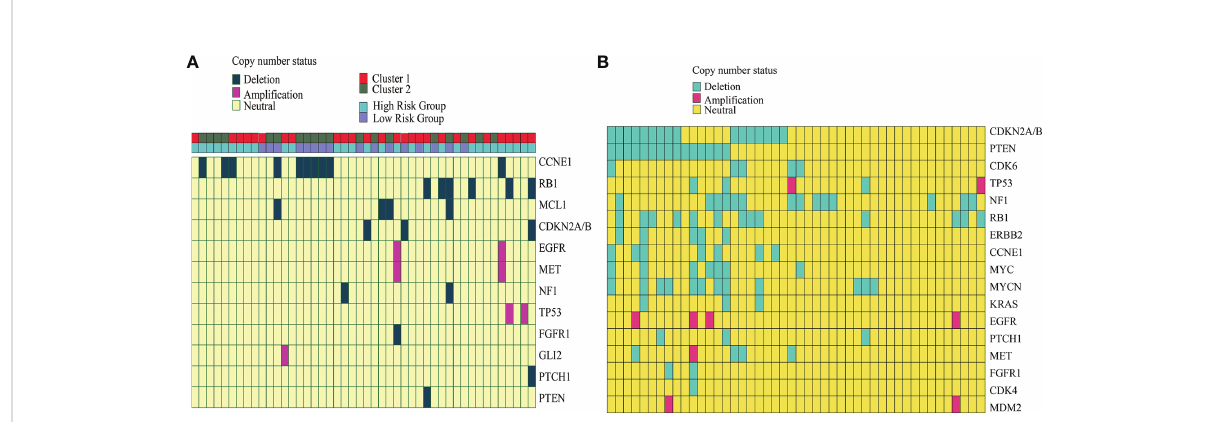
FIGURE 4 Copy number alteration of our cohort and the external GSE14068629 data set. (A) Copy number of the alteration plot of 46 chordoma patients and the corresponding cluster information from our cohort. (B) Copy number alteration plot of the 46 chordoma patients from the external GSE14068629 data